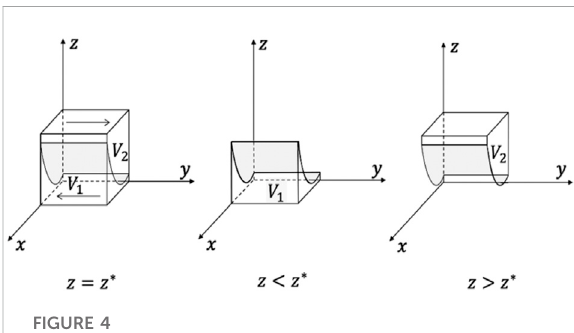
FIGURE 4 Phase diagram of recycling enterprises strategy